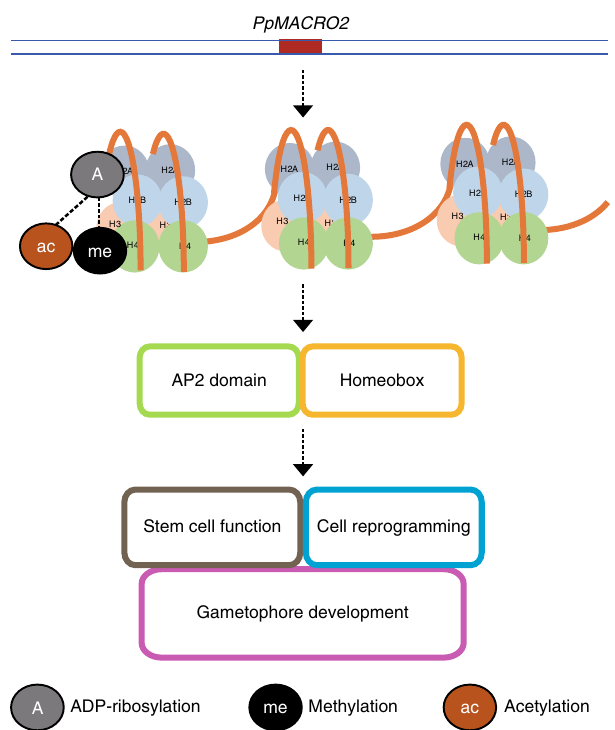
Fig. 7 A proposed model for PpMACRO2 in chromatin modi fi cation and development of P . patens . PpMACRO2 is likely involved in chromatin modi fi cation through ADP-ribosylation, which in turn triggers a cascade of additional chromatin changes via other epigenetic mechanisms, including histone methylation and acetylation. These epigenetic modi fi cation mechanisms may fi ne-tune chromatin conformation, which consequently activates/represses downstream developmental transcription factors (e.g., AP2 and homeobox) and affects stem cell function, cell reprogramming, gametophore development, and other biological processes. Dashed lines indicate that the relationship is less